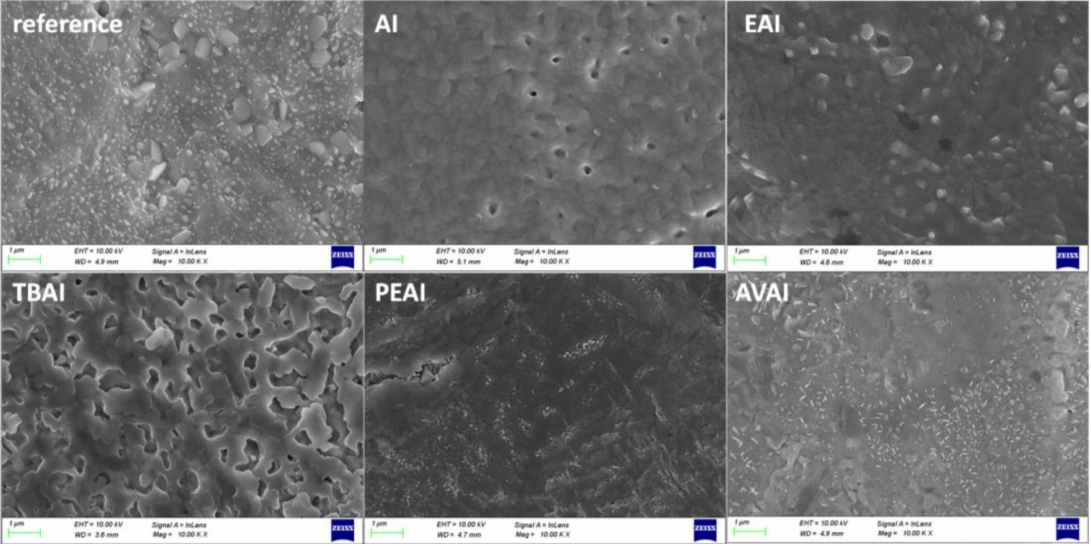
Figure 11. Top-view SEM images obtained for the perovskite films with and without post-treatment with the ammonium iodides under study.